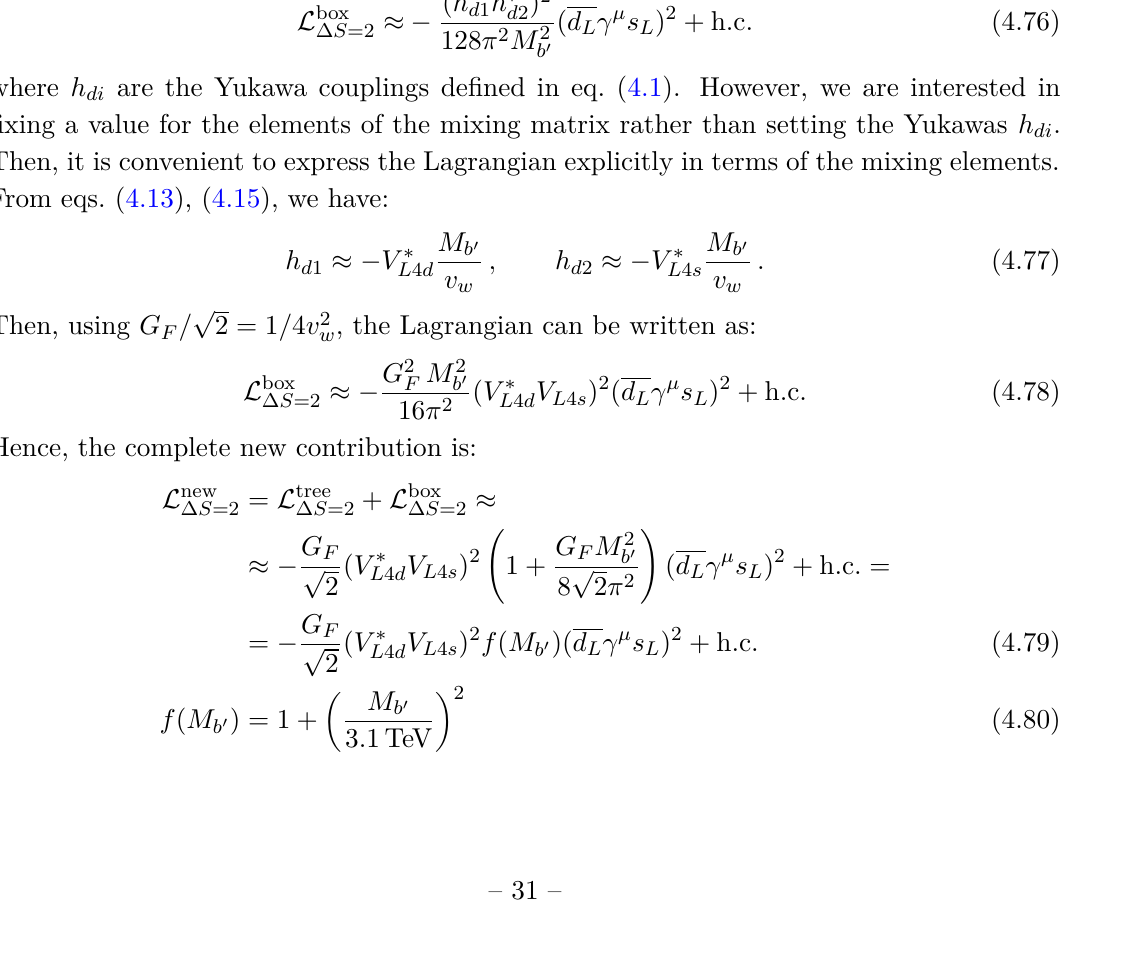
, b 0 in quark L R